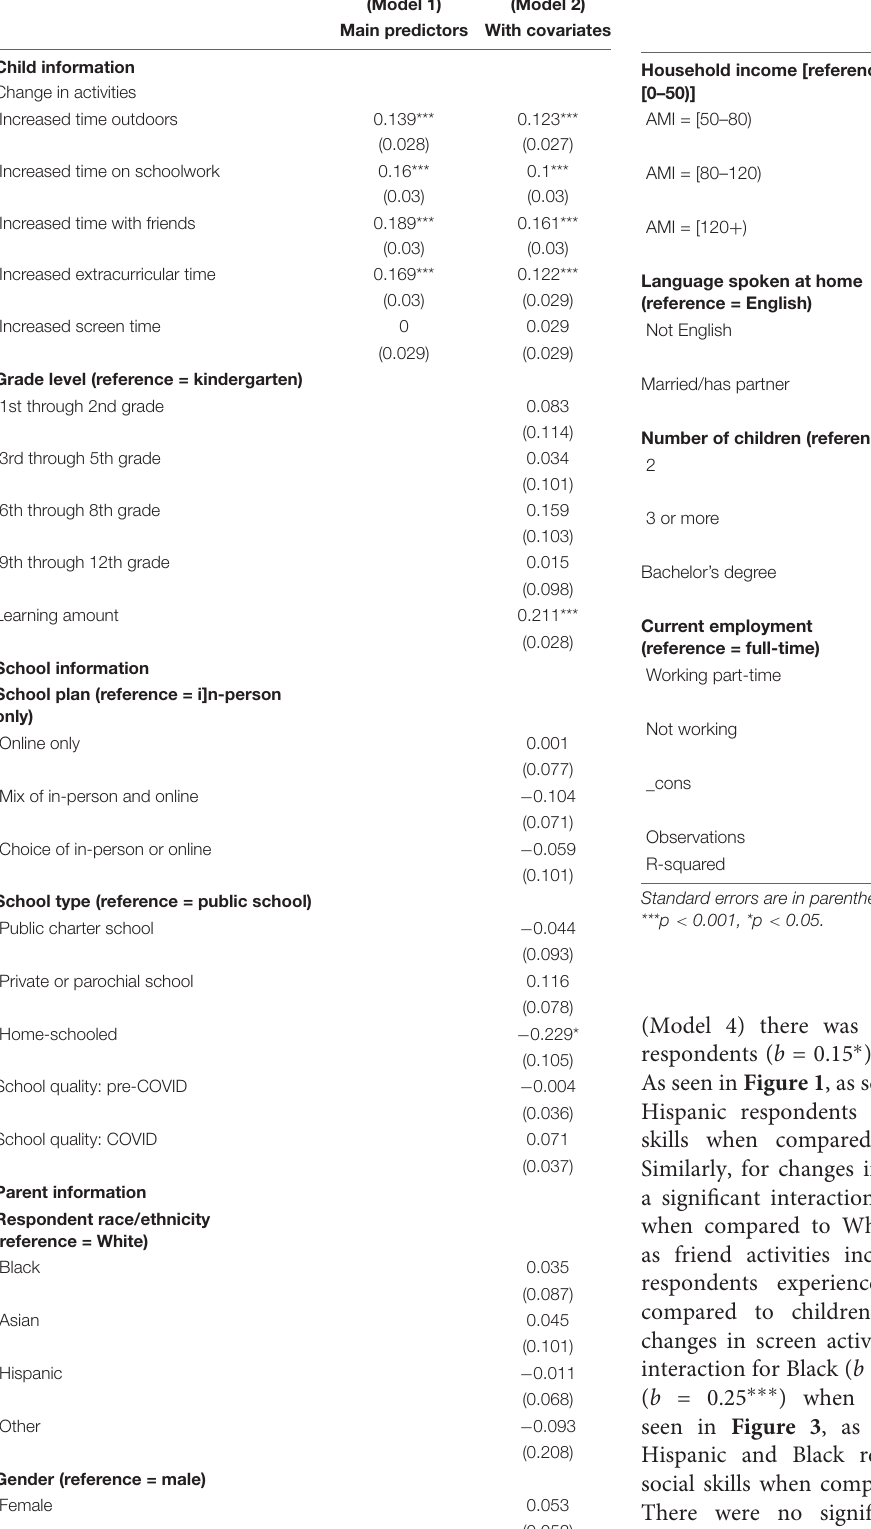
TABLE 2 | Child activities and social skills (outcome: increase in social